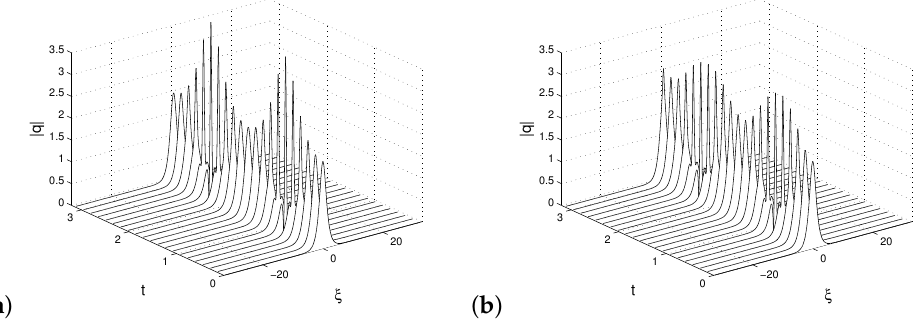
Figure 7. The full simulation of the NLS Equation (7) in ( a ) and DMD reconstruction ( b ) by